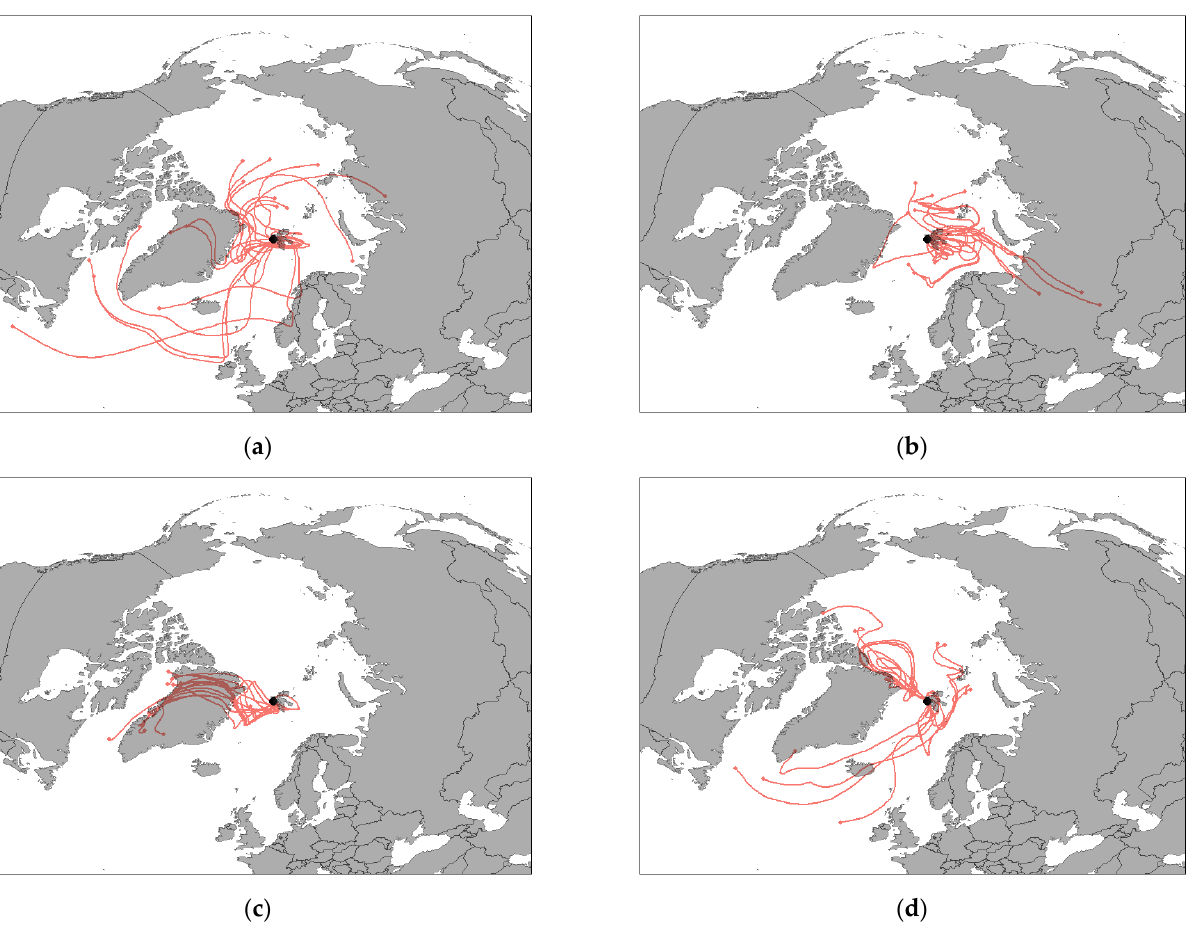
Figure 4. HYSPLIT back-trajectories calculated for two samples collected in spring: ( a ) 12 March, ( b ) 5 April; and for two samples collected in autumn: ( c ) 16 September and ( d ) 28 September.